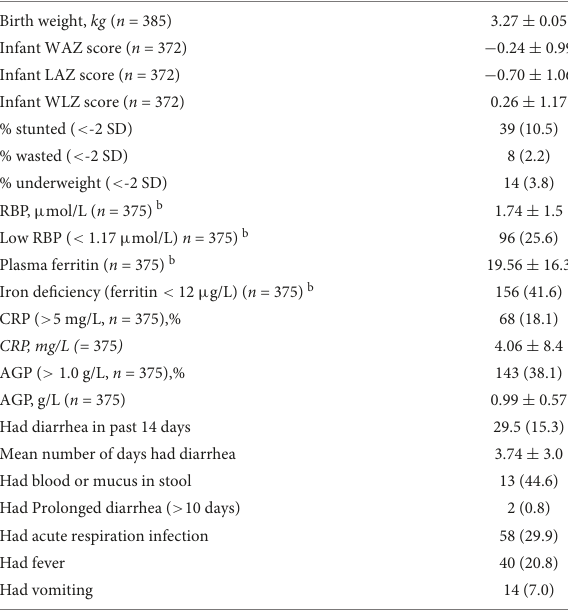
a Values are means ± SD, n = 385, or percent values within parentheses. LAZ, length- for-age Z-score; RBP, retinol-binding protein; WAZ, weight-for-age Z-score; WLZ,